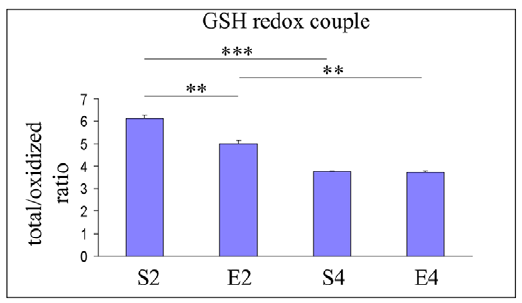
Figure 4. Glutathione redox status in hippocampi of mice undergoing 2- or 4-mo moderate treadmill running. Evaluation of the glutathione redox balance in hippocampi of mature CD1 female mice undergoing a two- or four-month moderate and regular treadmill- based exercise program (E2 or E4, respectively); age-matched sedentary animals (S2, S4) were used as controls (n=12 per group). A significant age-dependent decrease in the total vs oxidized glutathione ratio was found within mouse hippocampal formations (S4 vs S2). 2-mo running decreased the total vs disulfide glutathione ratio (E2 vs S2), whereas no significant change was induced by 4-mo exercise (E4 vs S4). Values were given as means 6 std. dev. The level of statistical significance was computed by using two-way ANOVA and post-hoc Newman-Keuls test: *** P , 0.001; ** P , 0.01. Experiments were performed in triplicate.